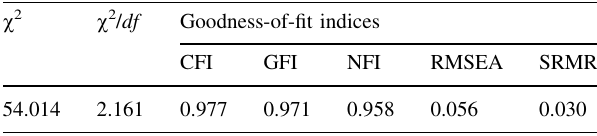
Table 3 Goodness-of-fit indices for the Chinese Version of the 10-item Conjoint Community Resilience Assessment Measurement in Aba Prefecture and Chengdu City, southwest